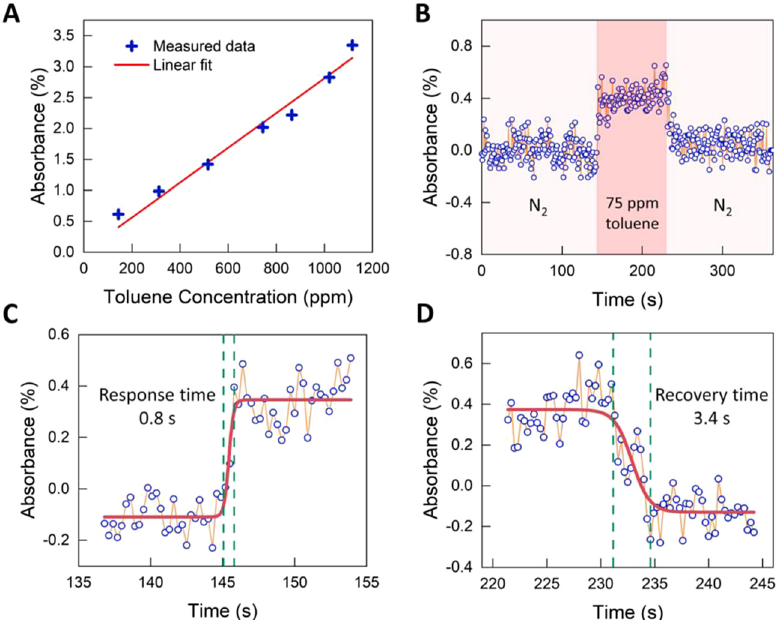
Figure 6: (A) Optical absorbance of toluene at its absorptionpeak of 6.65 µm versus toluene concentration.Theredlineisalinear fi ttingto the measured data. (B) Response and recovery characteristic cycle curves of the suspended silicon (Si) platform to alternative injection between pure N 2 and 75 ppm toluene-N 2 dilution. (C) Response time. (D) Recovery